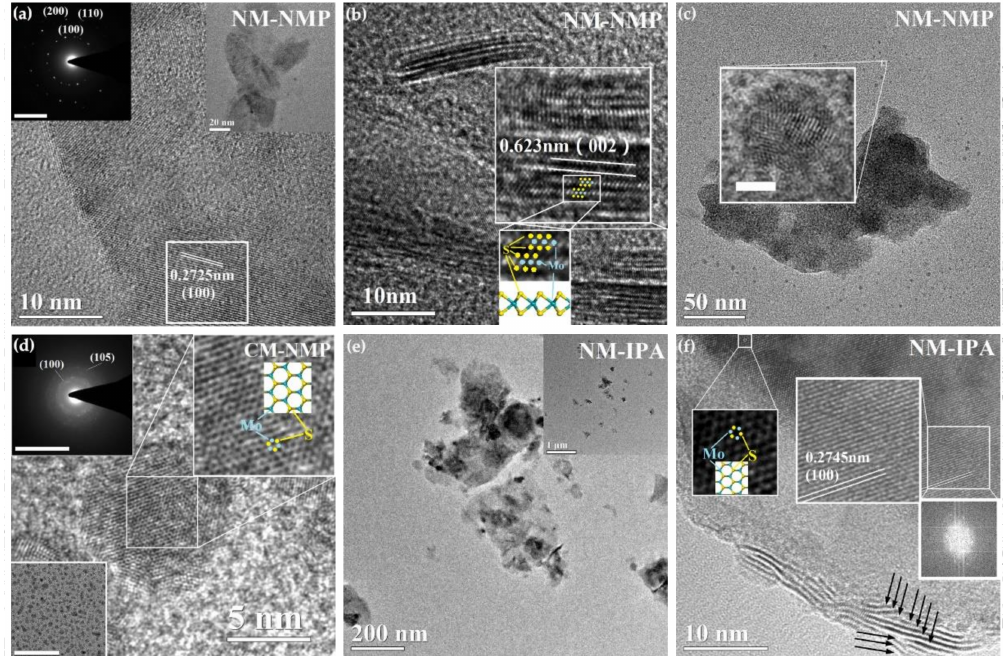
Figure 2. The high-resolution transmission electron microscopy (HRTEM) images of products exfoliated in N-methyl-pyrrolidone (NMP) from NM ( a , b , c ), CM ( d ), and products exfoliated in isopropanol (IPA) from NM ( e , f ). Insets in ( a ): a selected area electron diffraction (SAED) pattern, scale bar = 5 nm -1 , a low resolution image, scale bar = 20 nm; insets in ( b , f ): magnification of the selected area and schematic diagram of atomic arrangement; inset in ( c ): a quantum dot image, scale bar =2 nm; insets in ( d ): a SAED pattern, scale bar = 10 nm -1 , a low resolution image, scale bar = 50 nm, magnification of the selected area and schematic diagram of atomic arrangement; inset in ( e ): a low resolution image, scale bar = 1 µ